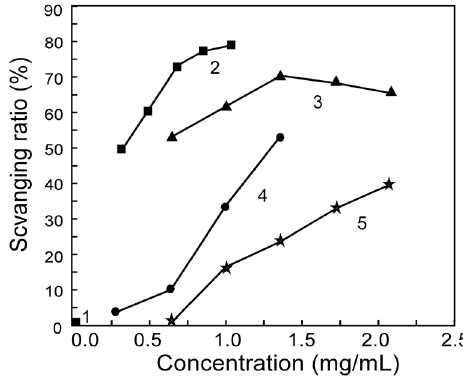
Fig. 5. UV spectrum of the POPs-I